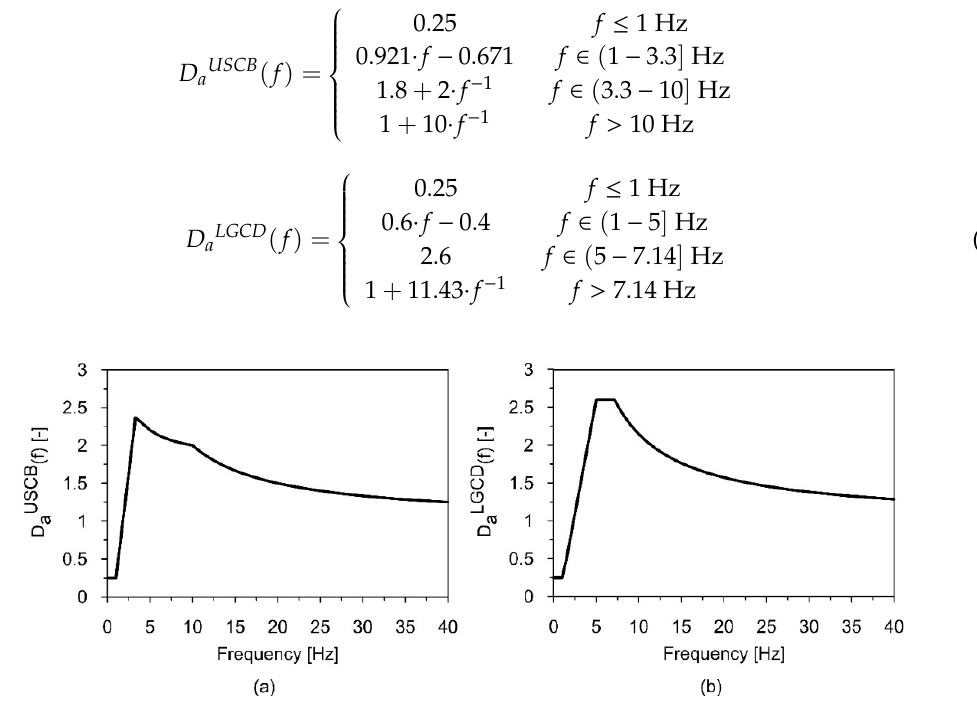
Figure 6. The response spectrum curves related to: ( a ) the USCB region; ( b ) the LGCD region.